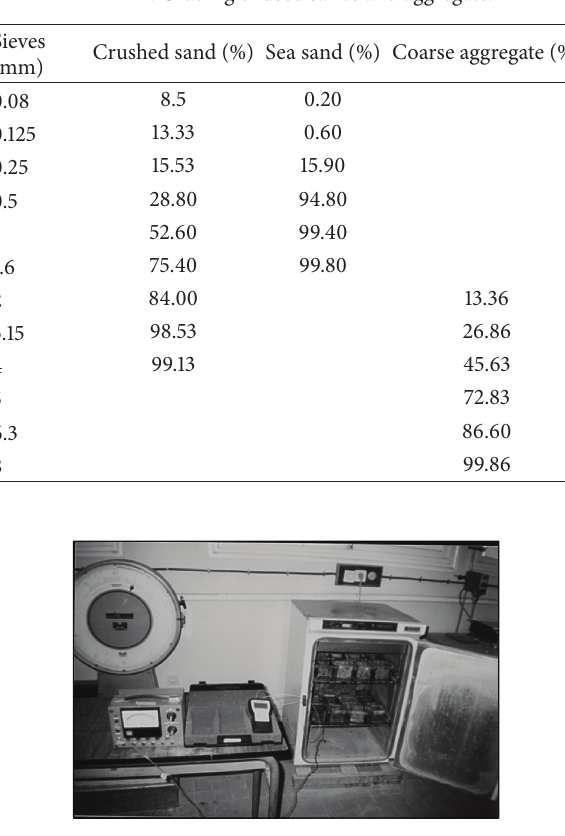
Table 1: Grading of used sands and aggregate.